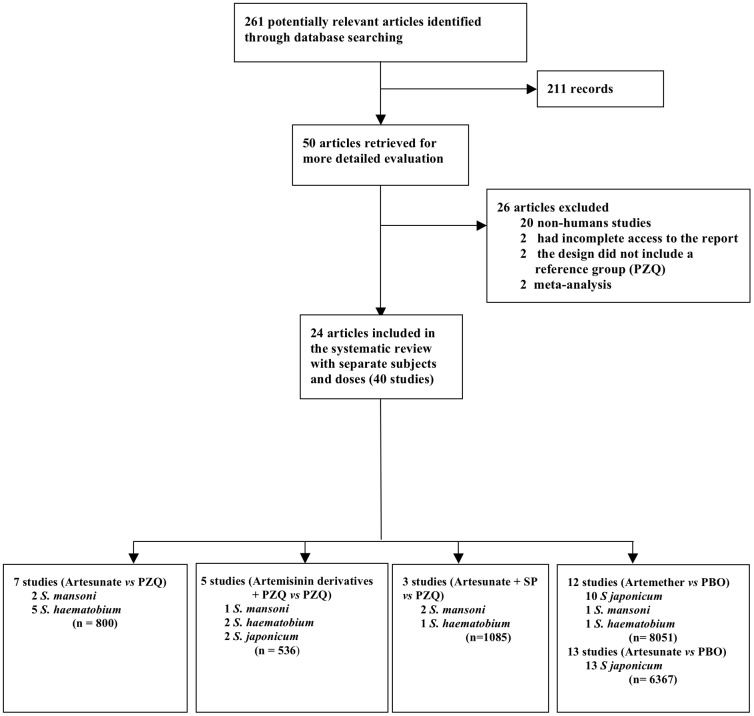
Flow diagram showing the selection process of studies included in the meta-analysis.